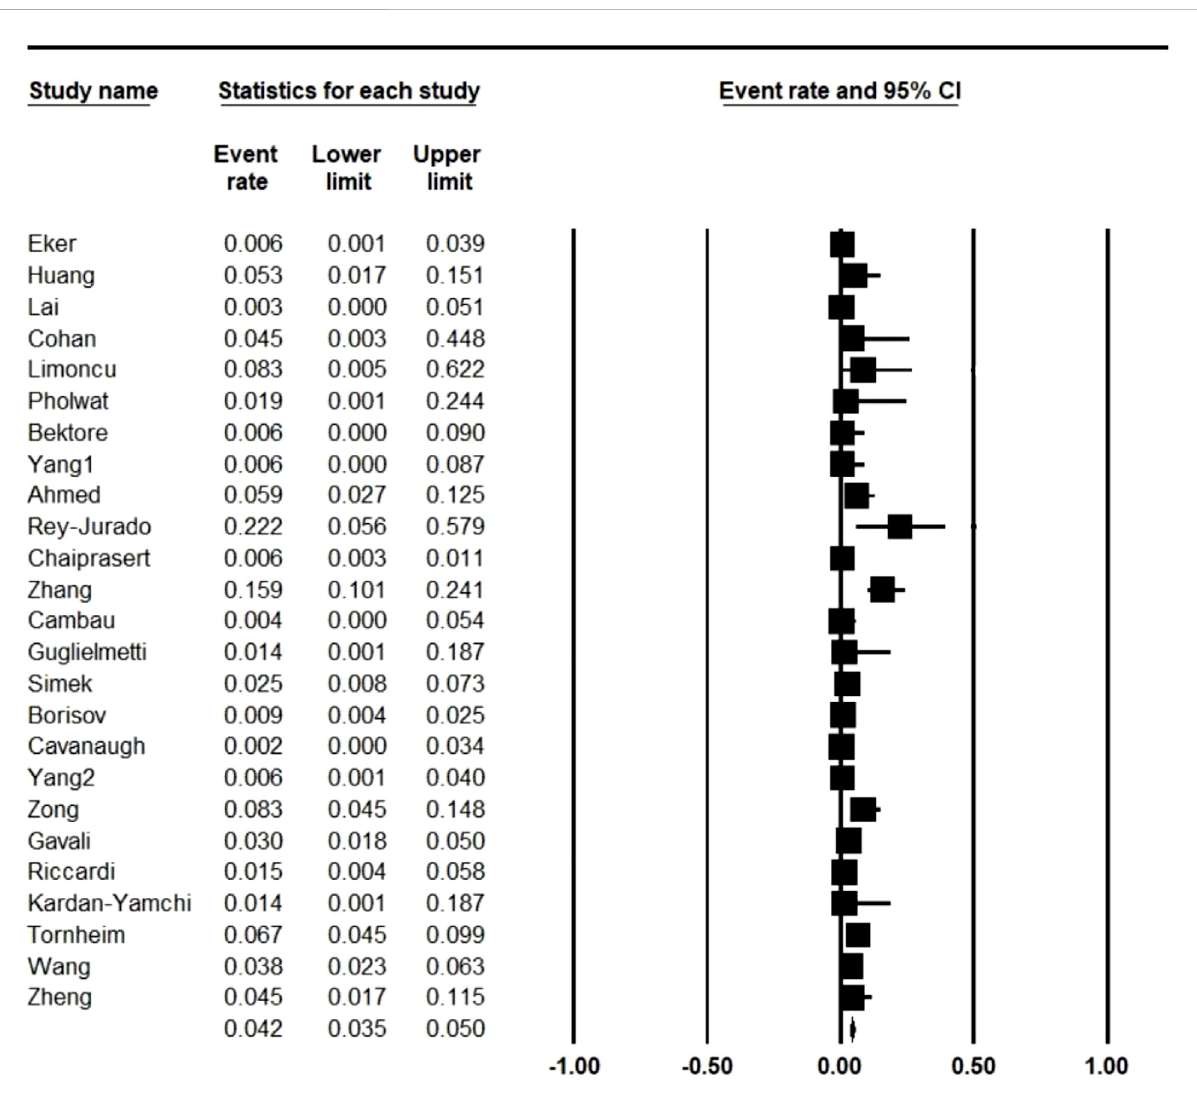
TABLE 2 Prevalence of linezolid resistance in MDR M. tuberculosis by countries. Country Number of study Number of MDR M.